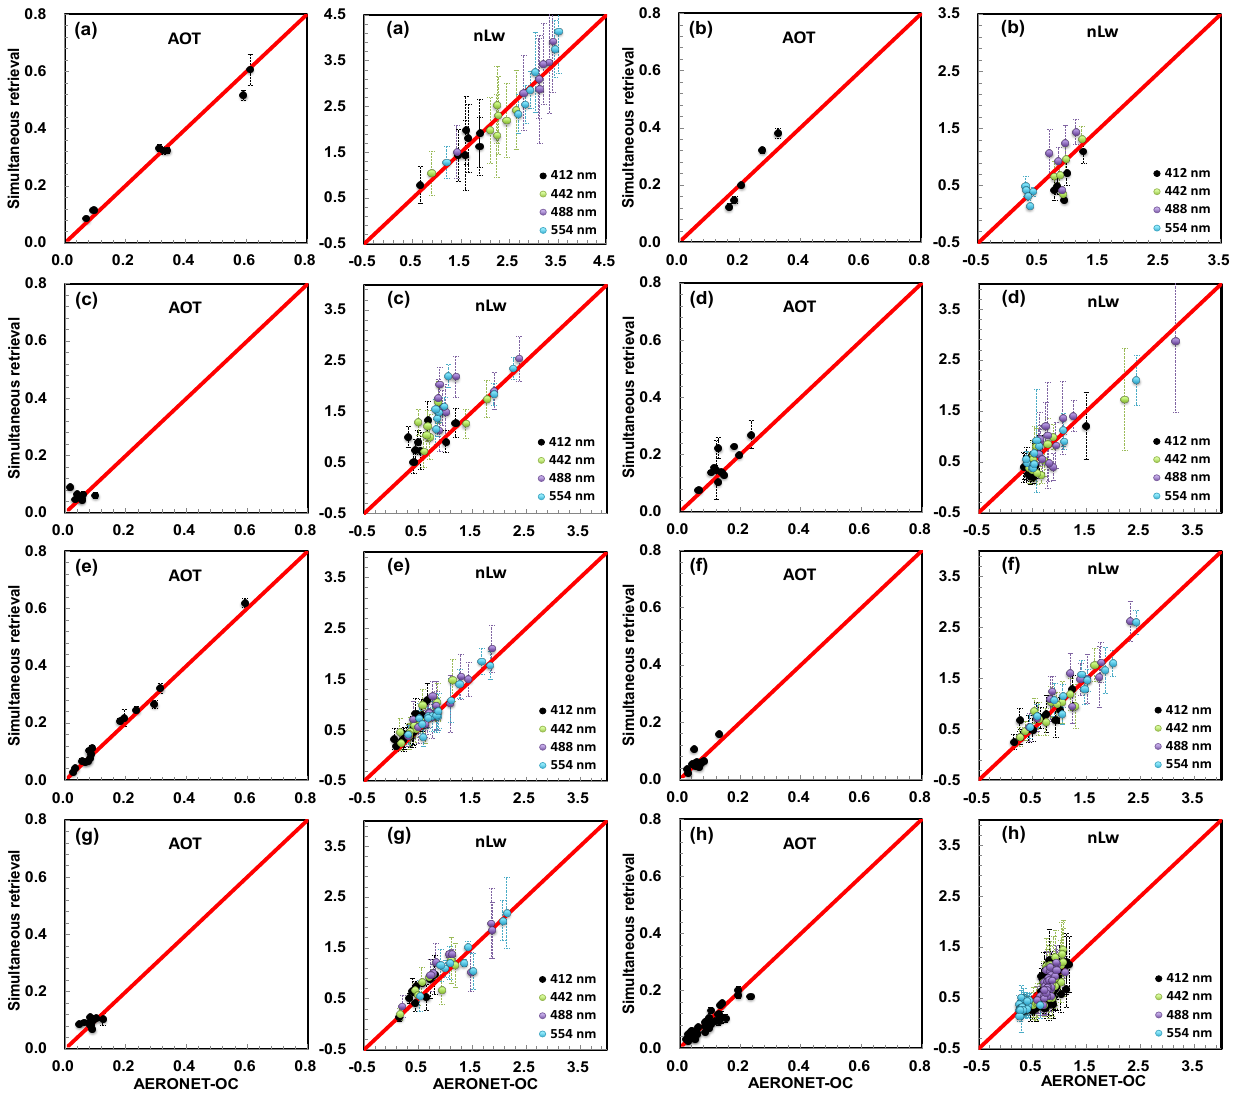
Figure 5. Comparison of simultaneously retrieved satellite AOT at 550nm and nL w (mwsr − 1 cm − 2 µm − 1 ) with AERONET-OC observa- tions. The red line represents the 1 : 1 line. (a) Ieodo_Station; (b) GOT_Seaprism; (c) Lucinda; (d) Abu_Al_Bukhoosh; (e)